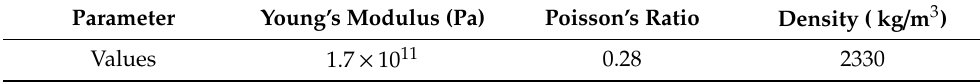
Table 2. Material parameters for FEM simulation.